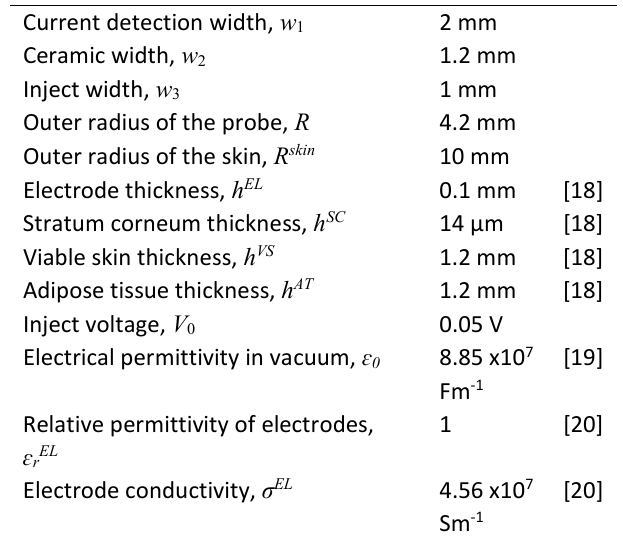
Tab. 1: Base-case dimensions and material parameters for the probe and skin layers.